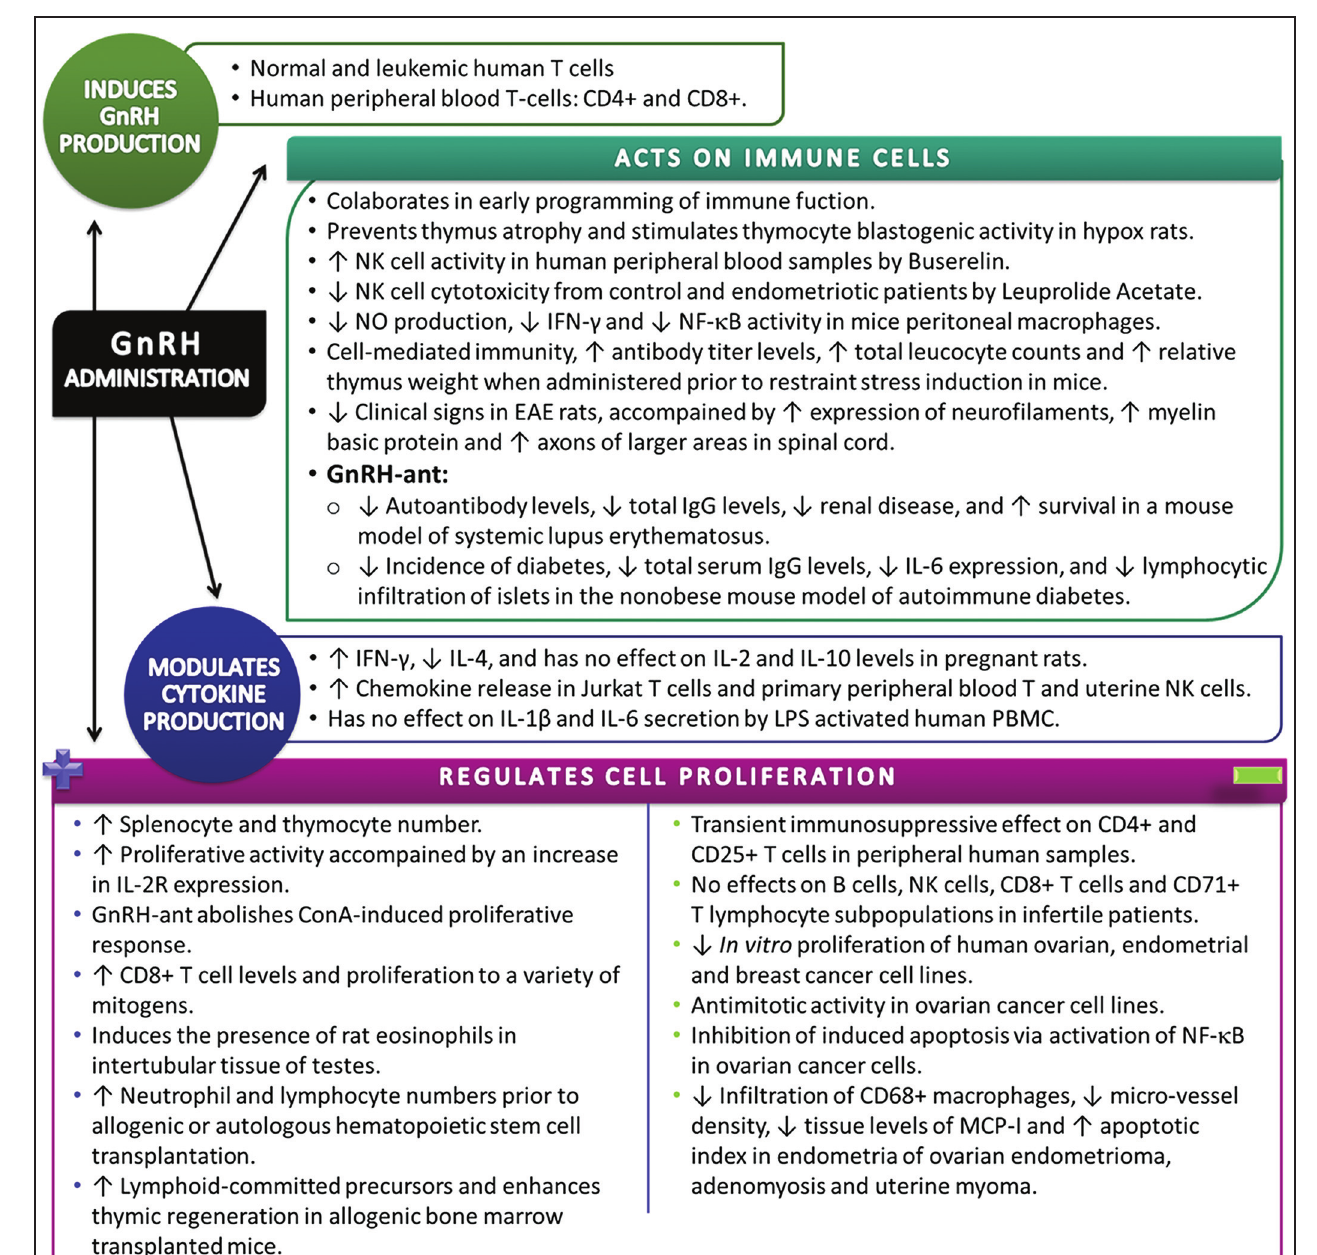
FIGURE 3 | Summary of experimental data showing the effects of Gonadotropin-Releasing Hormone/Gonadotropin-ReleasingHormone agonist on the immune system . Extrapituitary GnRH is implicated in a wide range of immunological processes, including direct cell immunomodulation and proliferative responses ( ↑ = increase, ↓ =